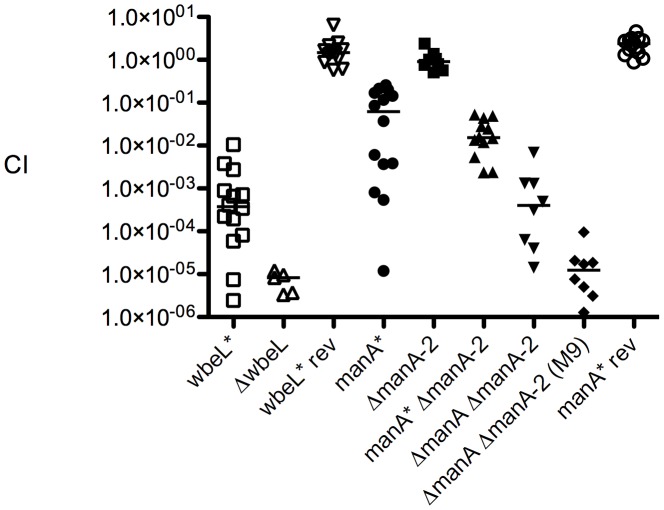

V. cholerae O1 phase variants are attenuated in vivo.Competition indices (CI) were determined between the strains indicated and the parental strain carrying a lacZ deletion in infant mice 24 hours post infection. Each symbol represents the CI for an individual mouse and horizontal lines indicate the median CI for each strain.